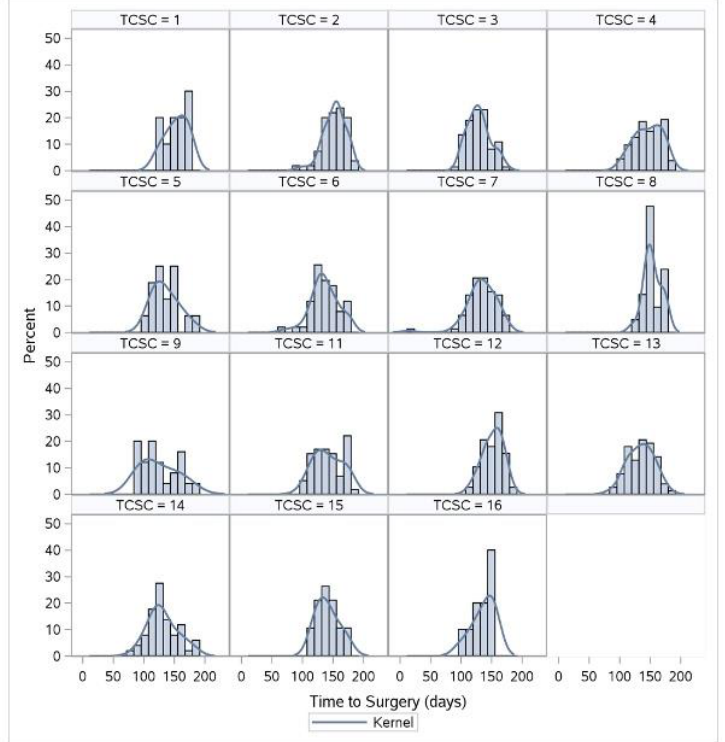
Figure 3. Bar chart demonstrating the comparison of the time to surgery for esophageal cancer distribution amongst thoracic cancer surgery centers in Ontario between 2013 and 2018. 3.2. Changes in TTS and TTC lengths by TCSC after Adjusting for Covariates